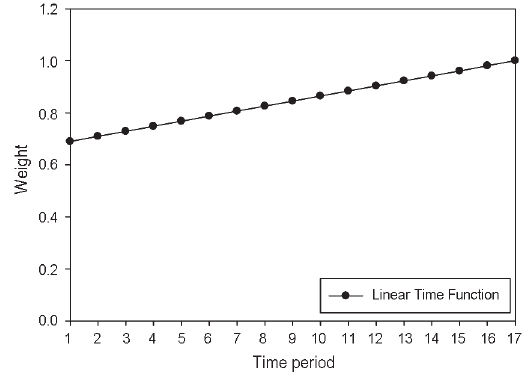
Fig. 5. Linear time function